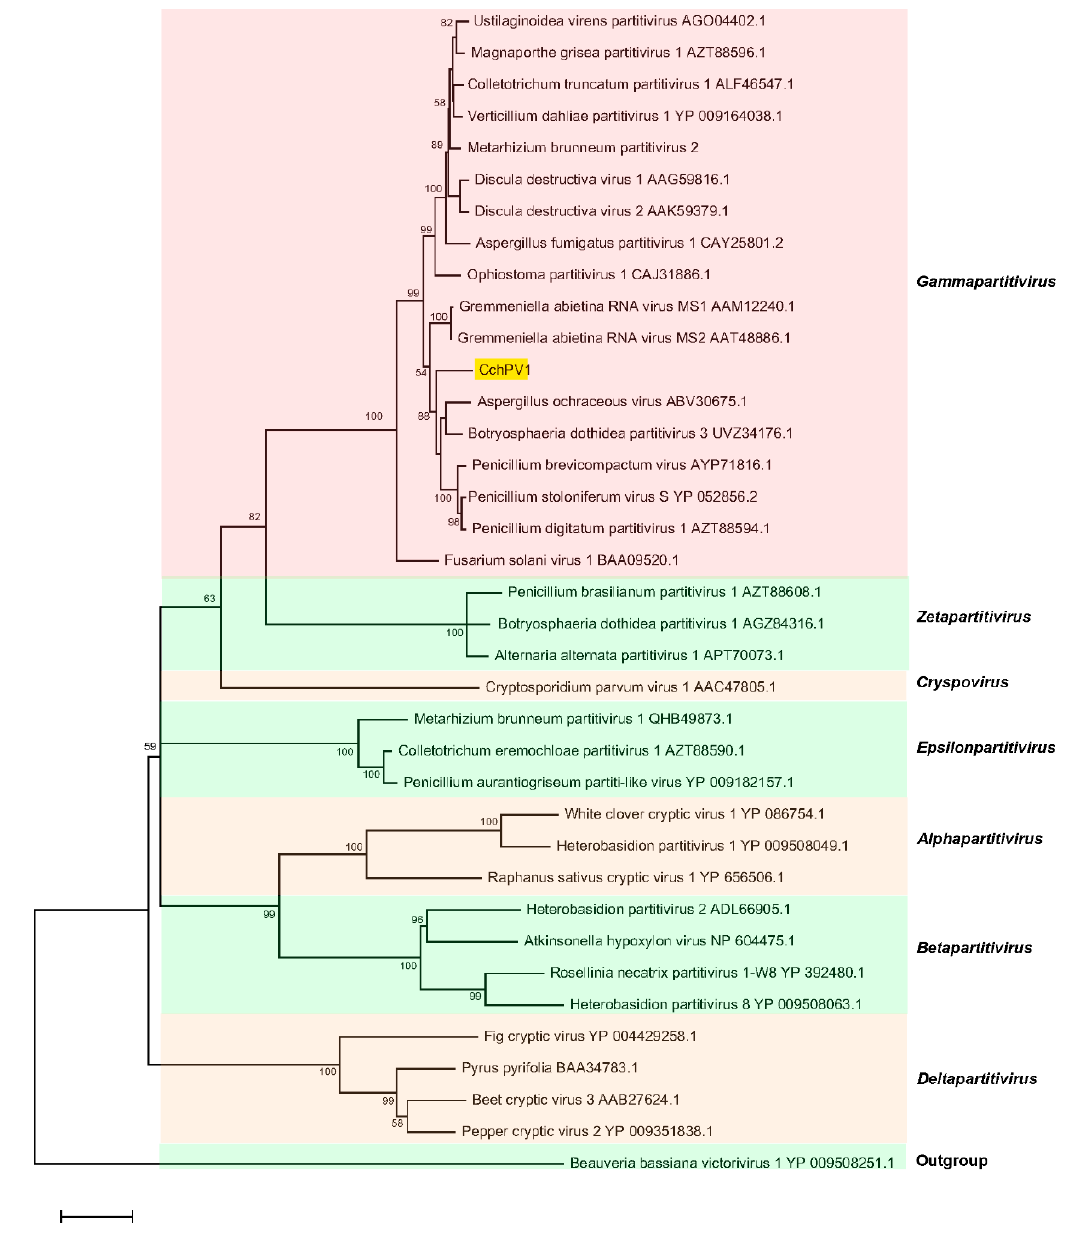
Figure 3. Phylogenetic analysis of RdRp of CchPV1 and the other members of the family Partitiviridae , including members of the genera Alphapartitivirus , Betapartitivirus , Gammapartitivirus , Deltapartitivirus , and Cryspovirus , as well as the proposed genera “ Epsilonpartitivirus ” and “ Zetapartitivirus ”, con- structed using the maximum likelihood method (ML), with the LG + G + I + F amino-acid substitution model. The scale represents 0.5 amino-acid substitutions at each site, and the numbers on the nodes indicate bootstrap support of more than 50% (1000